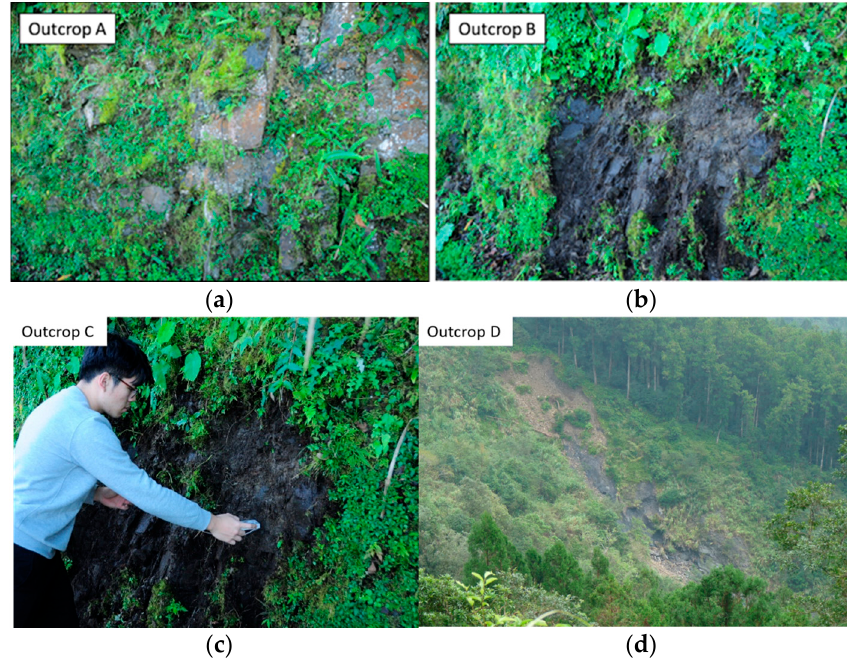
Figure 13. Photographs of out-crops in field: ( a ) out-crop A, ( b ) out-crop B with the moist black fault gouge material, ( c ) out-crop C also showing moist black fault gouge material, and ( d ) photo taken in October, 2015 after Typhoon Soudelor showing out-crop D with moist black material exposed.